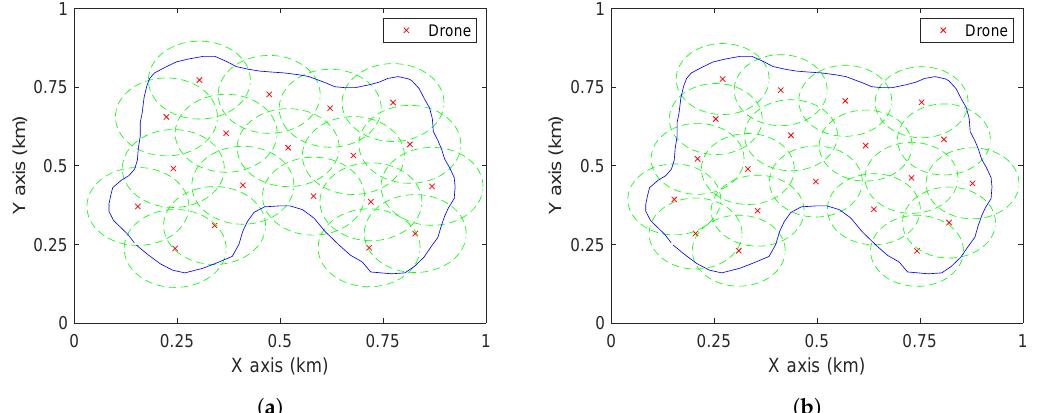
Figure 8. The deployments by the algorithm of [19]. ( a ) N = 19 and the drones are at the altitude 114 m. ( b ) N = 20 and the drones are at the altitude 108